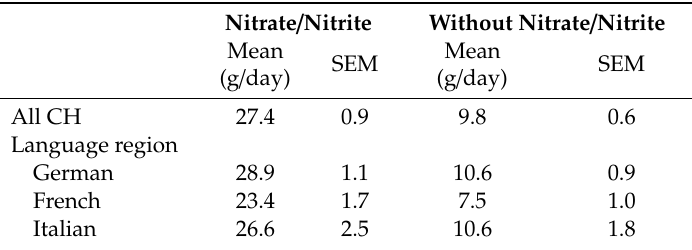
Table 3. Mean daily intake of processed meats with or without the preservatives nitrate / nitrite for the total population (all CH) and by language region (g /